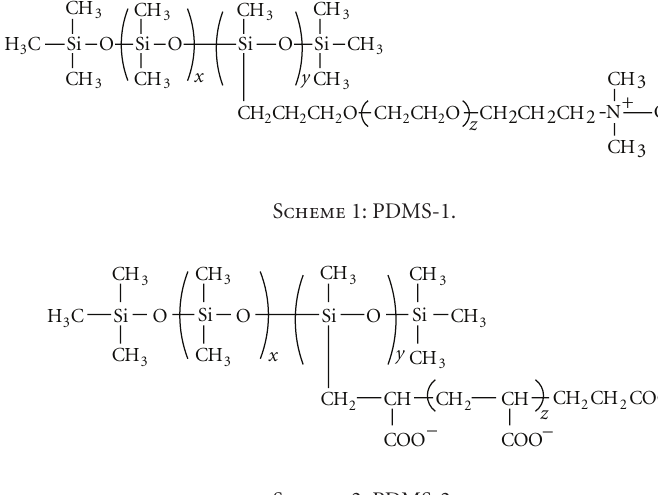
Scheme 1: PDMS-1.